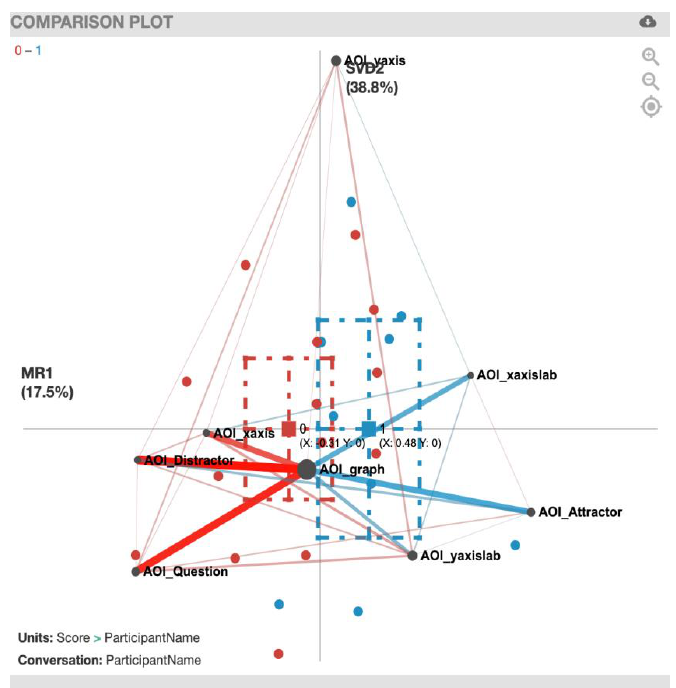
Figure 5. EcAreaQual transitions with incorrect solvers (red) and correct solvers (blue). MR1 presents a variance of 17.5% and SDV2 presents a variance of 38.8%.